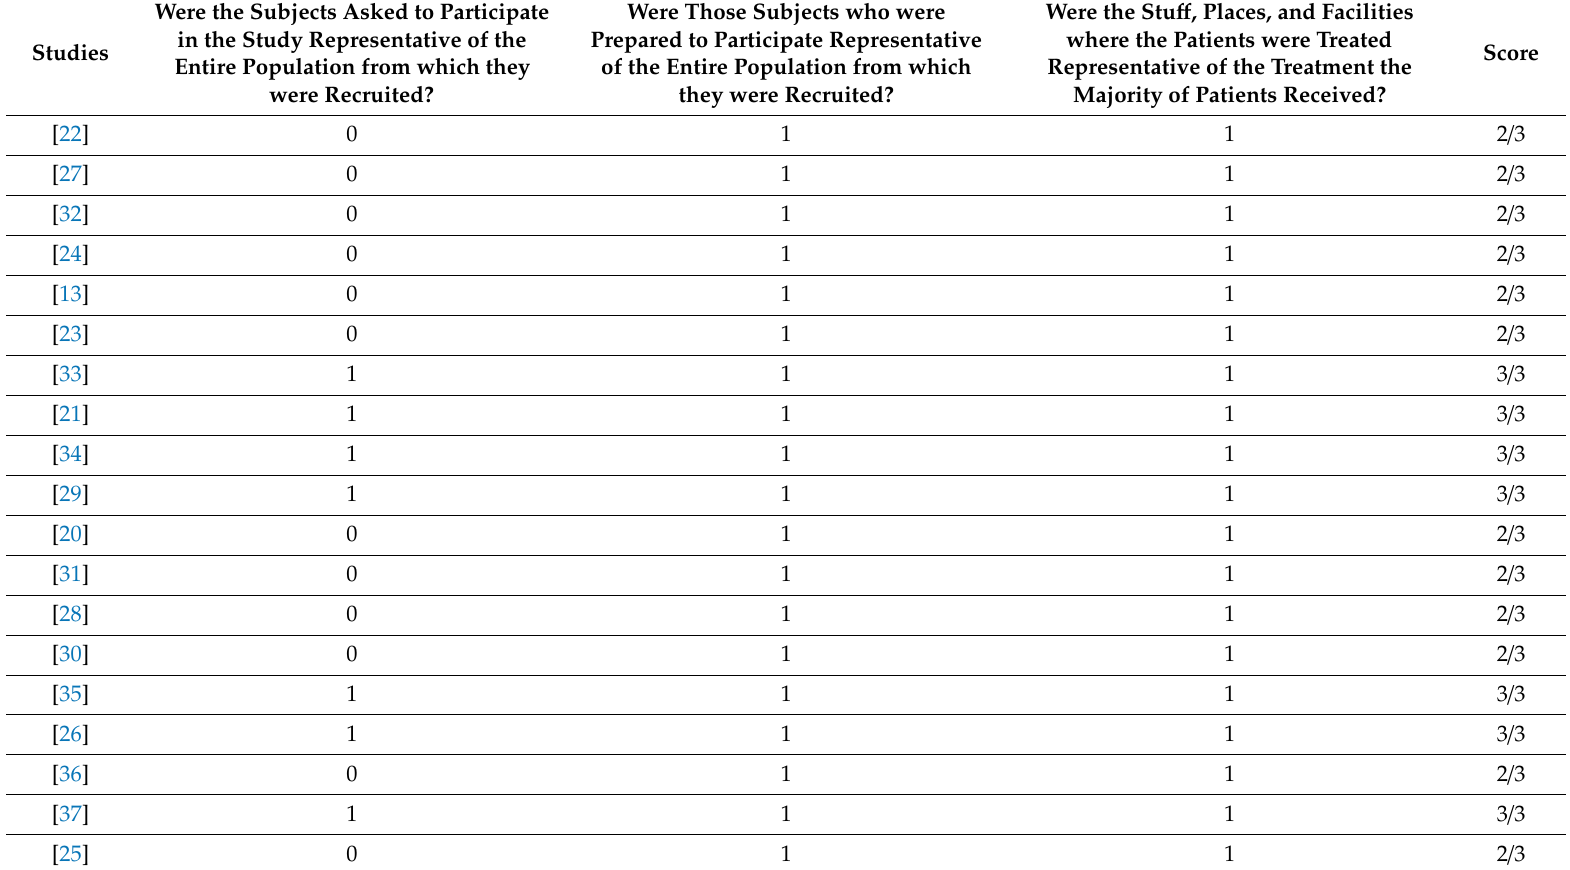
Table 4. Summary of the checklist for measuring external